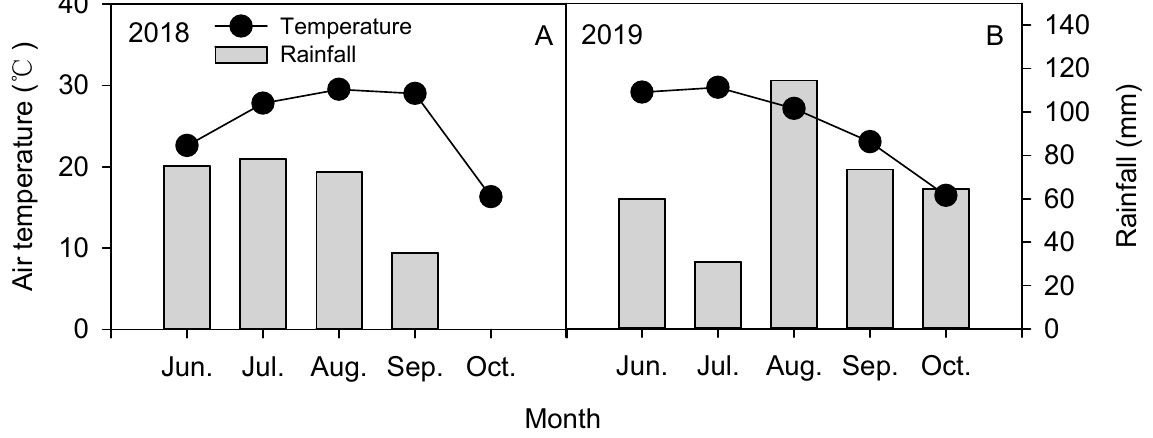
Figure 1. Mean monthly air temperature and rainfall during the 2018 ( A ) and 2019 ( B ) growing seasons.